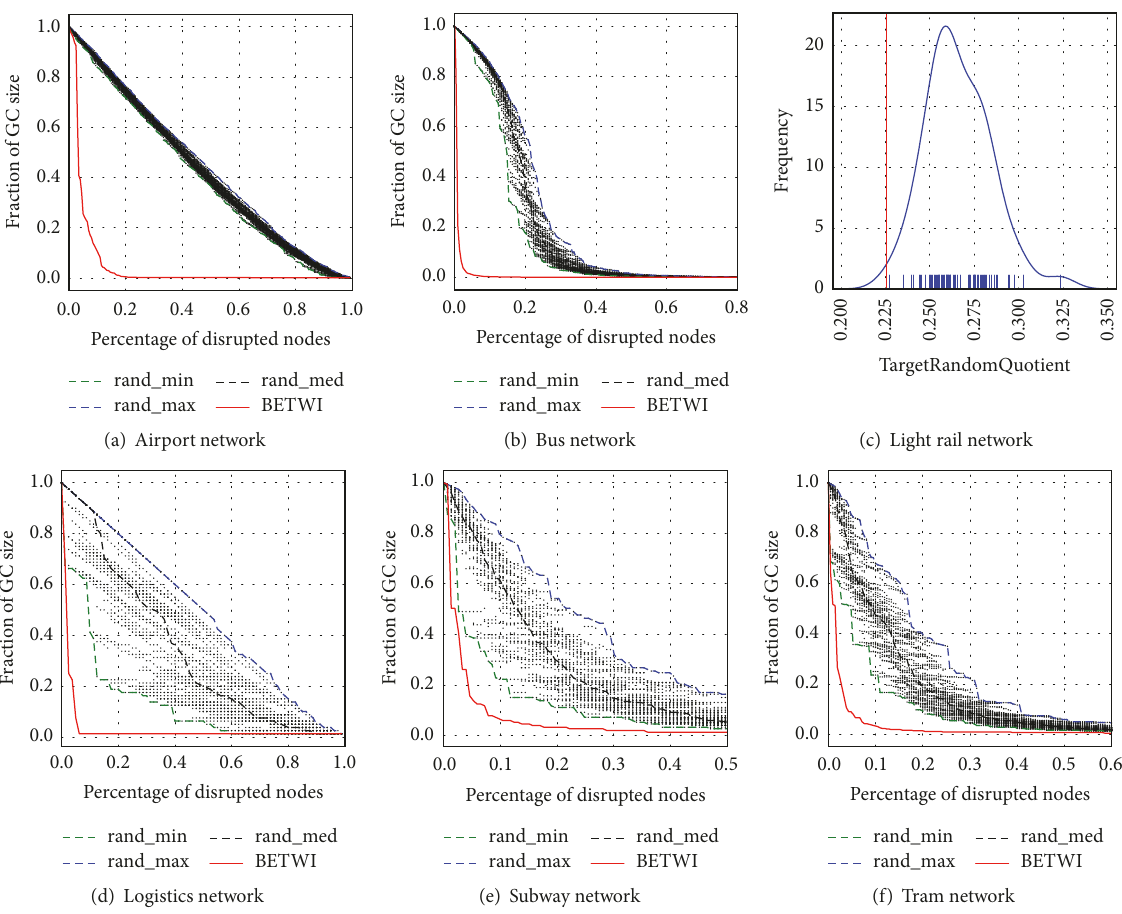
Figure 7: Comparison of random attack envelopes and the best known attack BETWI on six transportation networks, as described in